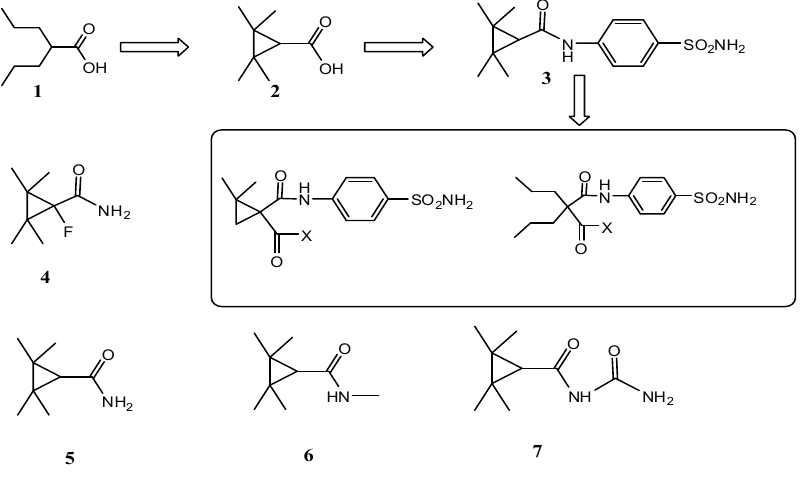
Figure 1. Structure of AEDs and designed